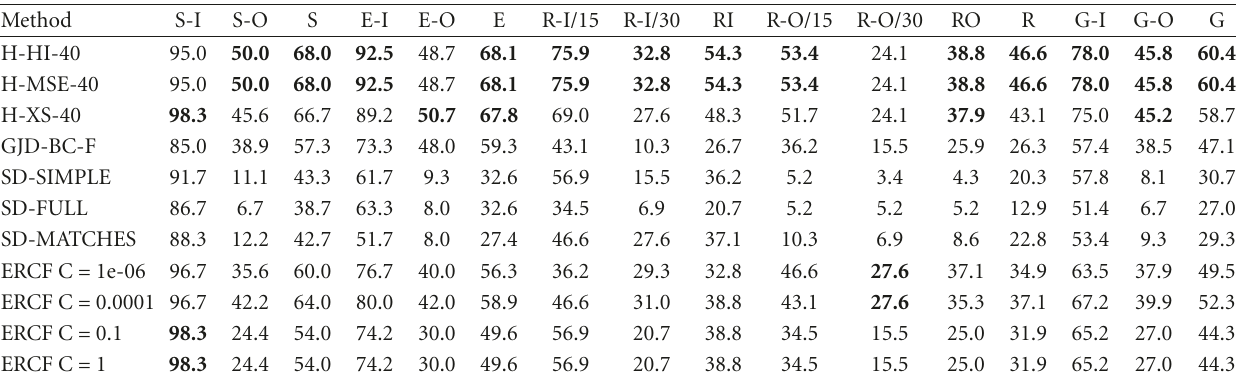
Table 6: UCHFaceHRI tests. Top-1 recognition rate. Experiments are performed with detected eyes. In bold are the best results for each condition. Methods that have di ff erences of 1% or less are considered as having the same performance. See main text for a description about the di ff erent